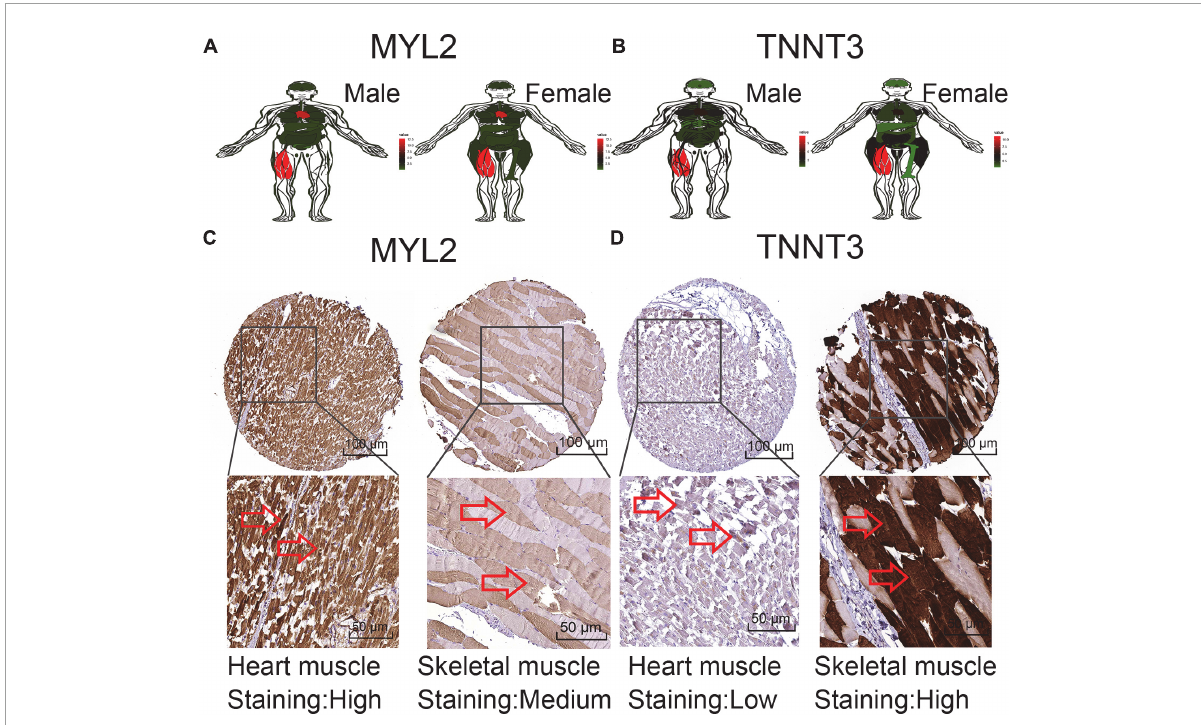
FIGURE5 Expression of sudden death characteristic genes in human tissues. (A,B) MYL2 and TNNT3 expression levels in tissues in males and females. (C) Validation of MYL2 in turquoise module by HPA (IHC). (D) Validation ofTNNT3 in turquoise module by HPA (IHC). Red represents high expression, green represents low expression, and black represents mediate